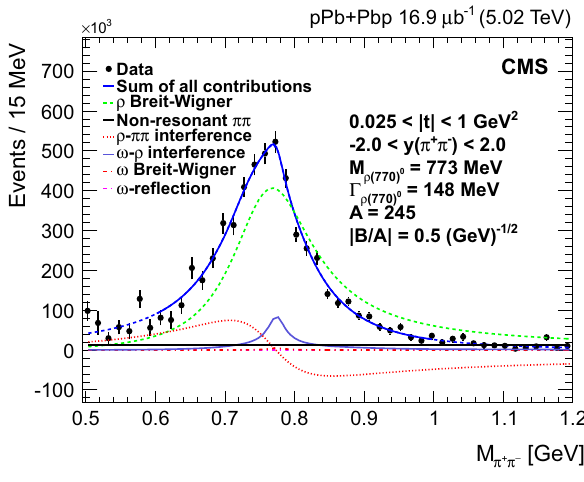
+ π − Fig. 3 Unfolded π invariant mass distribution in the pion pair rapidity interval | y + − | < 2 . 0 (full circles) fitted with the modi- π π fied Söding model. The results of the fit are also given (see text for details). The green dashed line indicates resonant ρ ( 770 ) 0 production, the red dotted line the interference term, the black dash-dotted line the non-resonant contribution, the dark blue dashed line the interference between ρ ( 770 ) 0 and ω ( 783 ) , and the blue solid line represents the sum of all these contributions